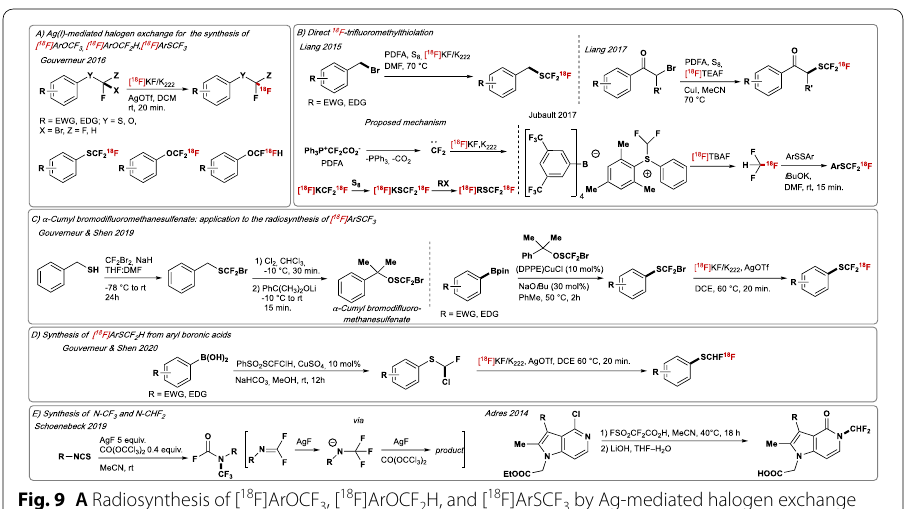
Fig. 9 A Radiosynthesis of [ 18 F]ArOCF 3 , [ 18 F]ArOCF 2 H, and [ 18 F]ArSCF 3 by Ag-mediated halogen exchange with [ 18 F]fluoride. B [ 18 F]trifluoromethylthiolation with difluorocarbene precursors and [ 18 F]fluoride. C Radiosynthesis of [ 18 F]ArSCF 3 from aryl boronic esters. D Radiosynthesis of [ 18 F]ArSCHF 2 from aryl boronic acids. E Synthesis of N-CF 3 and N-CF 2 H. EWG electron-withdrawing group, EDG electron-donating = =